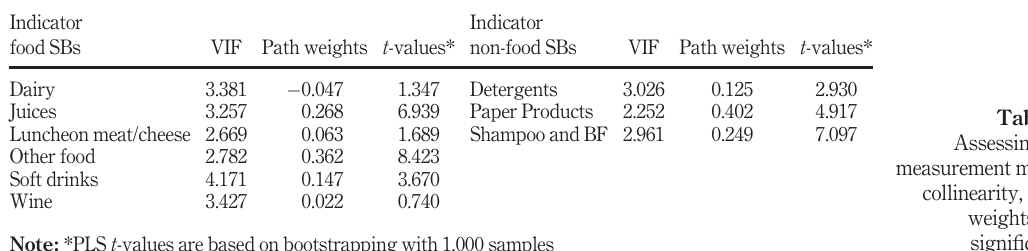
measurement model: collinearity,